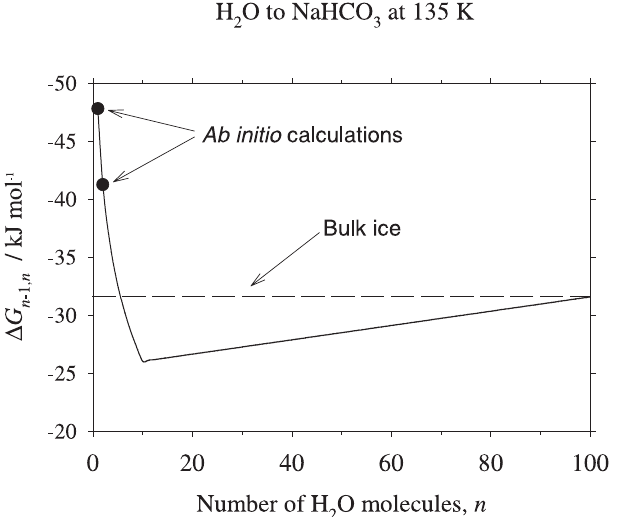
and a selection of 3